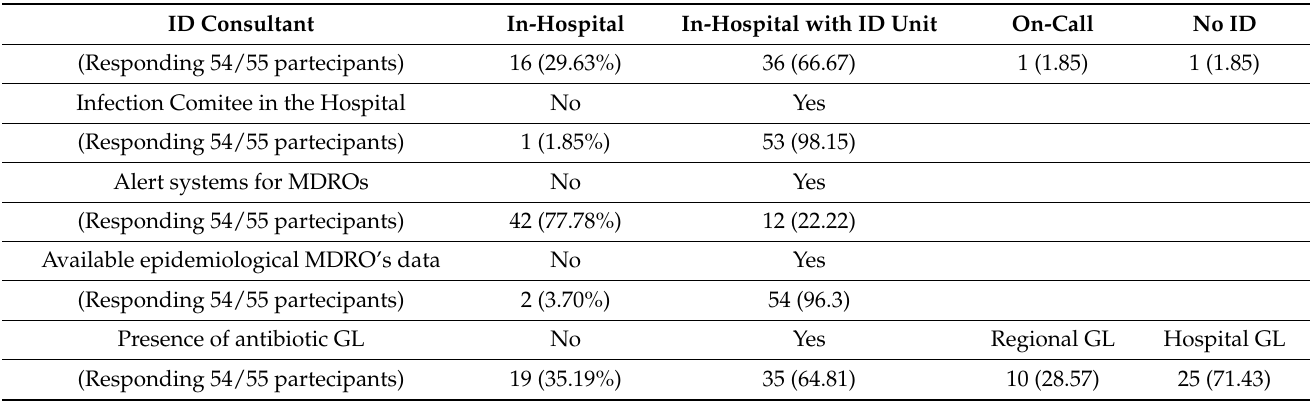
Table 2. Information regarding infectious disease specialist and infection control